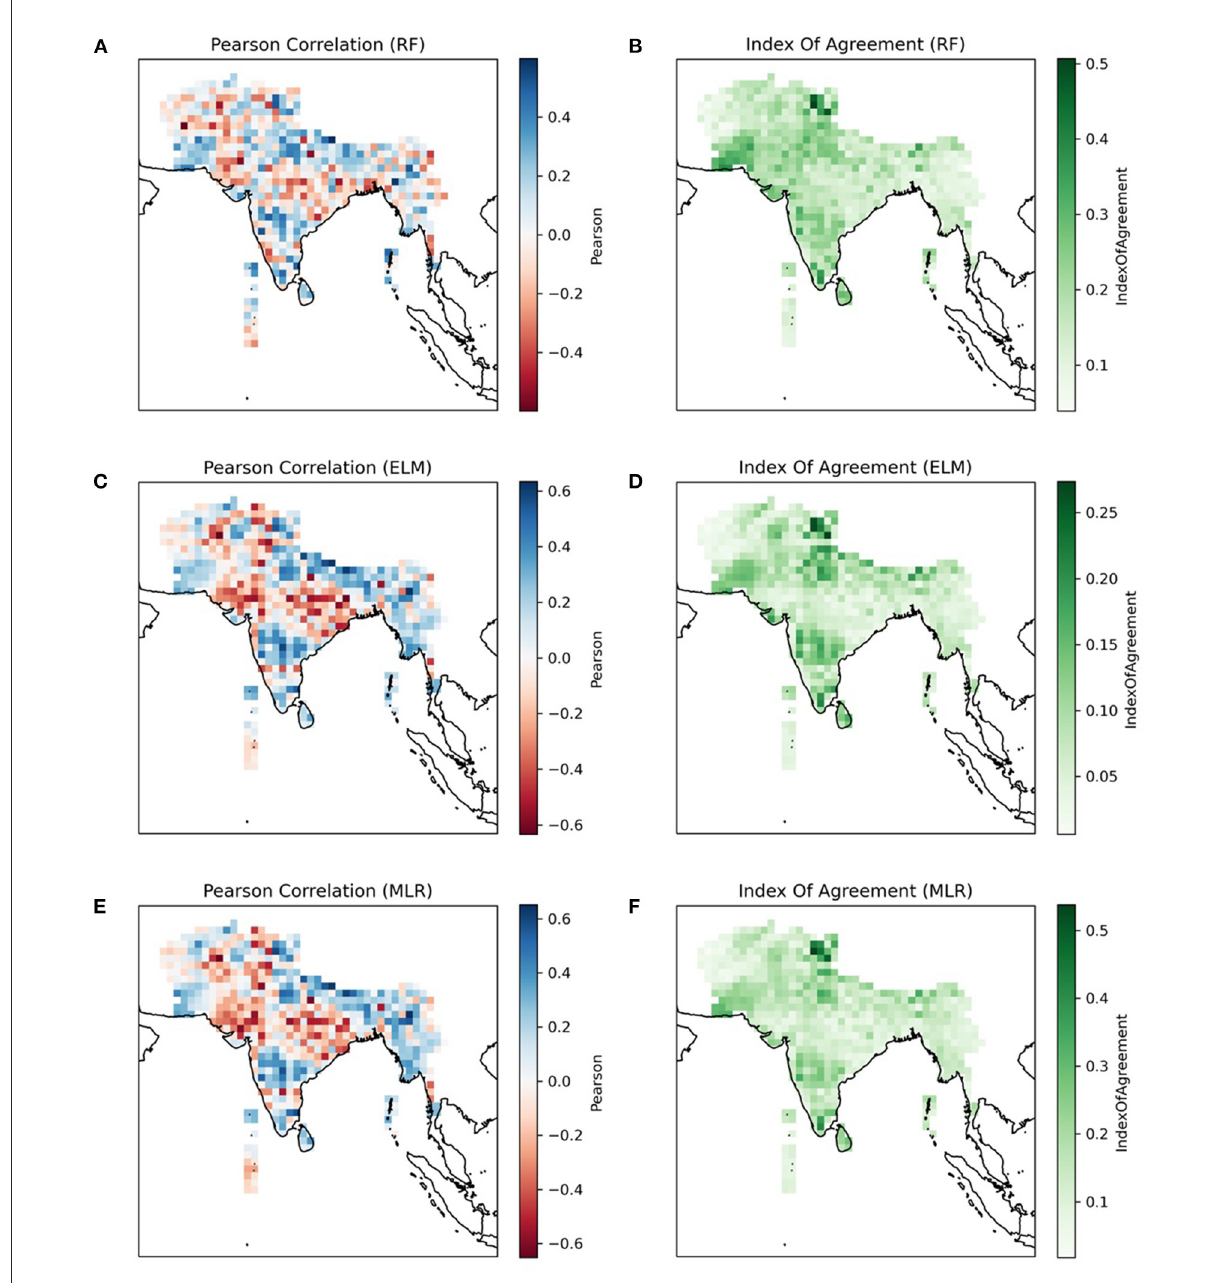
The difference between XCast and